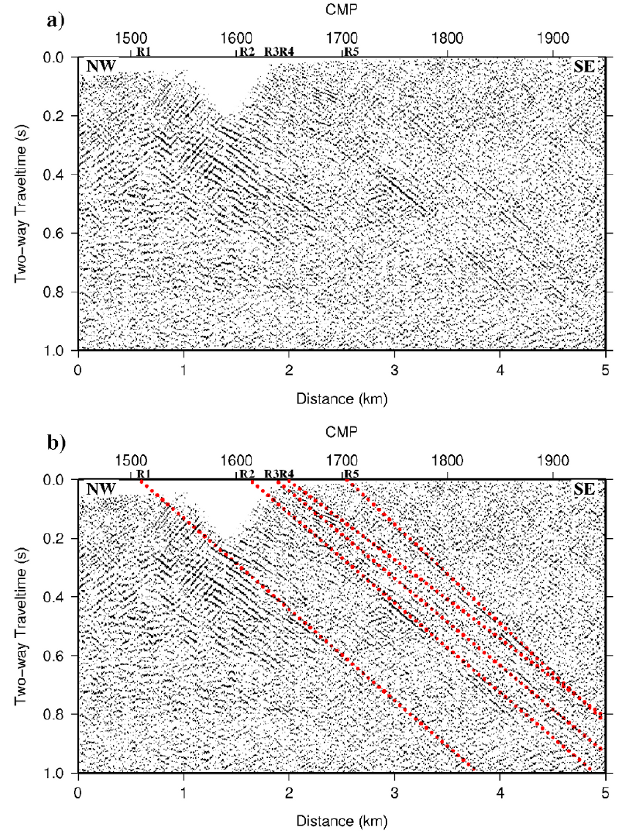
Fig. 7. Parts of unmigrated stack of S.P. 2 using high stacking ve- locities. (a) Without and (b) with calculated travel-times for reflec- tions R1–R5